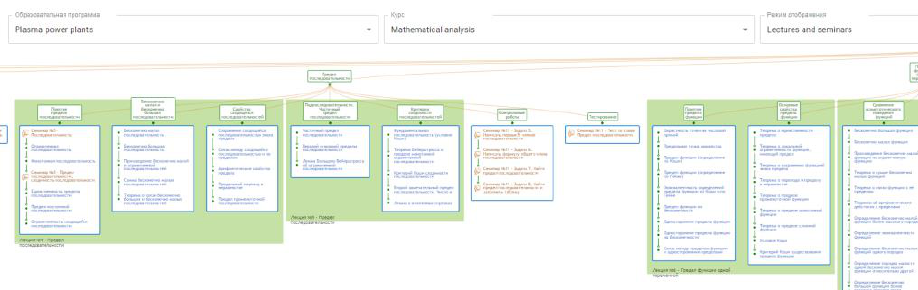
Fig. 3. The structure of the course "Mathematical analysis" for engineering specialties